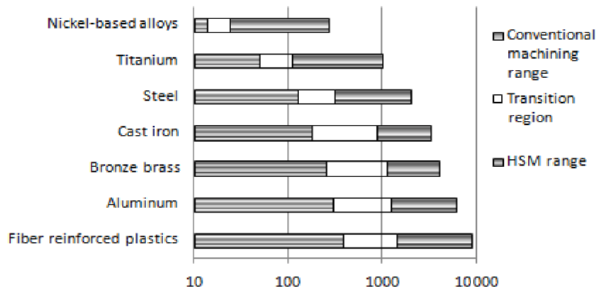
Figure 8. Cutting speed ranges for machining of different materials (data from Schulz and Moriwaki,